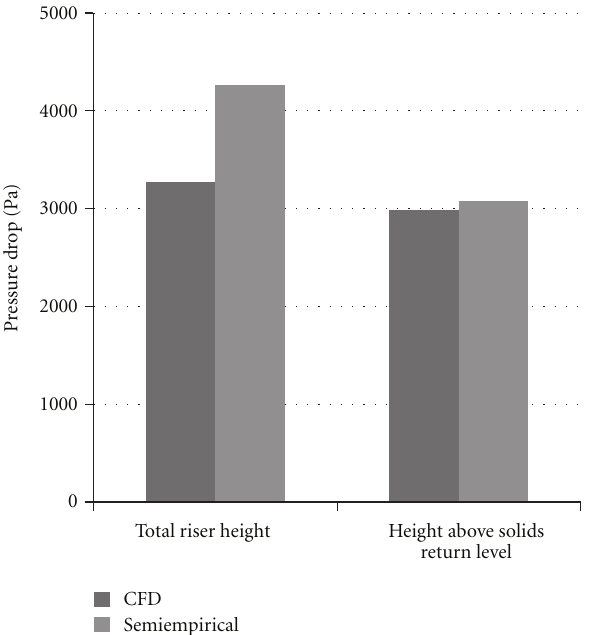
Figure 5: Pressure drop in the riser as given by the semiempirical model and the CFD simulations.